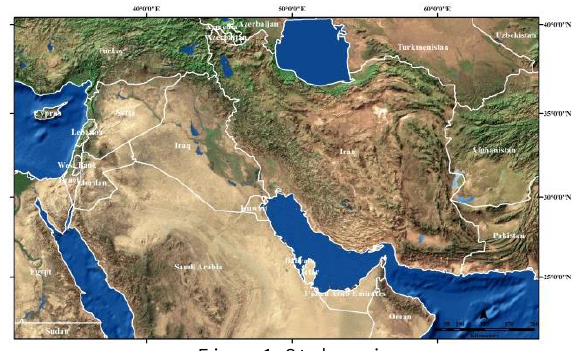
Figure 1. Study region